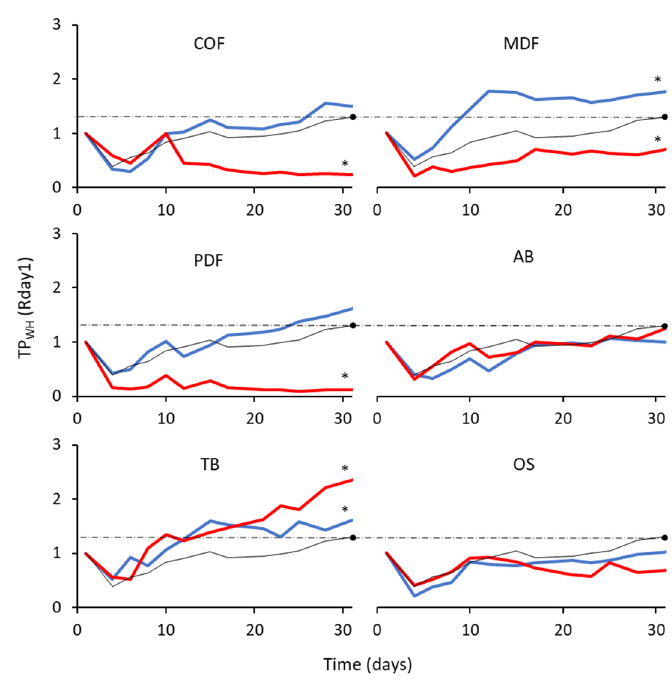
Figure 6. Surface coverage of Sedum hispanicum plants on green roof substrates with different biochars (T = 450 °C) in different application ratios (1 wt.% = blue, 5 wt.% = red, control = black, and endpoint of control = dashed black) over a period of 30 days. An asterisk (*) indicates a statistically significant difference from the control ( p < 0.05). COF = coffee husks, MDF = medium-density fiberboard, PDF = palm date fronds, AB = AB wood waste, TB = tree bark, and OS = olive stones.